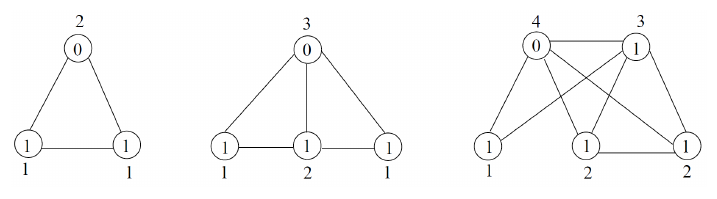
Figure 2: Non-antiregular graphs with an antiregular total dominating